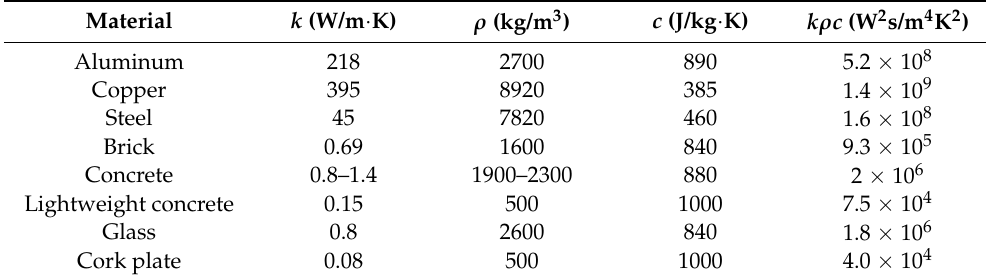
Table 1. Thermal inertia parameters of some